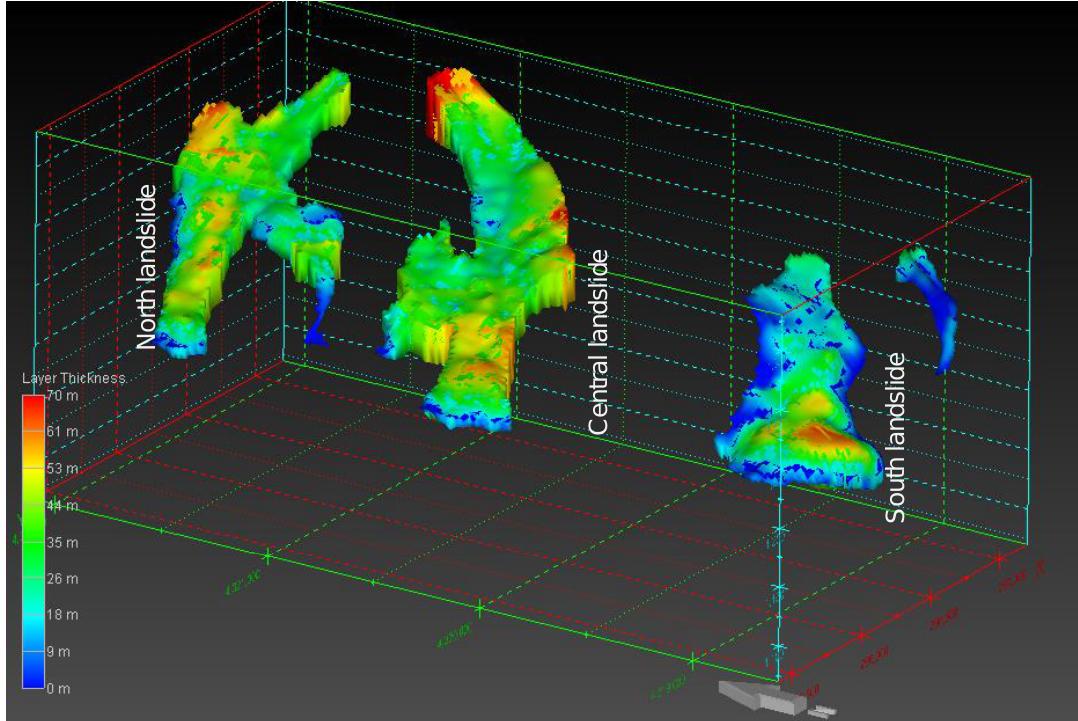
Figure 4. Oblique view of north, central, and south active landslide complex (Alsc), showing thickness of deposits with a vertical exaggeration of 3 times (modified from [2]).